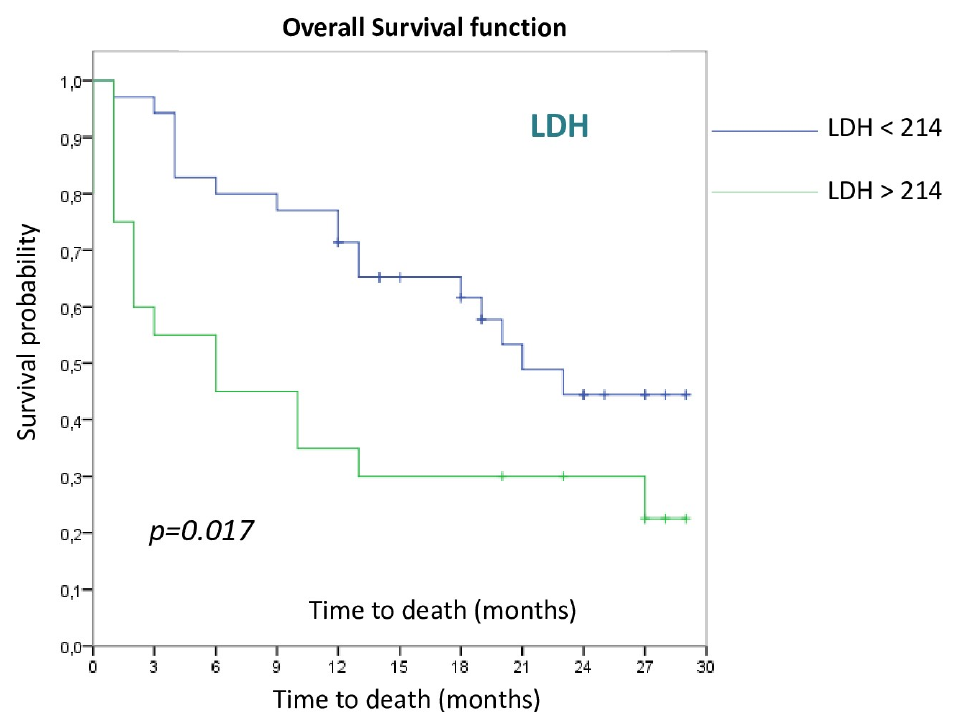
Figure 2. Overall survival curves according to LDH.